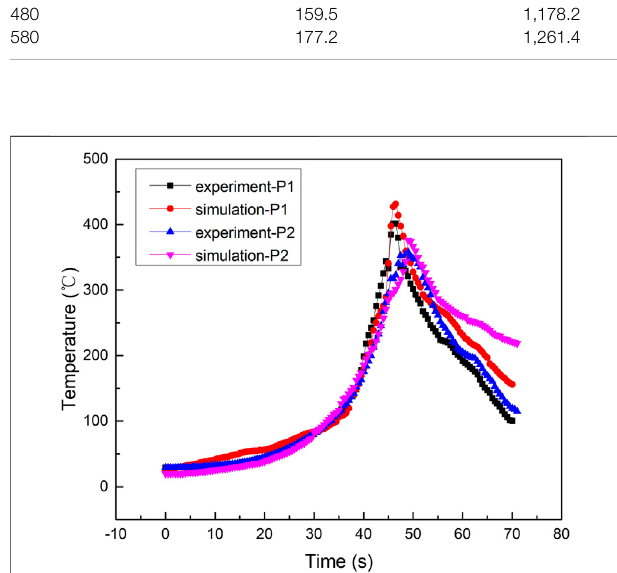
FIGURE 4 | Temperature change of the P1 and P2 location during the process.